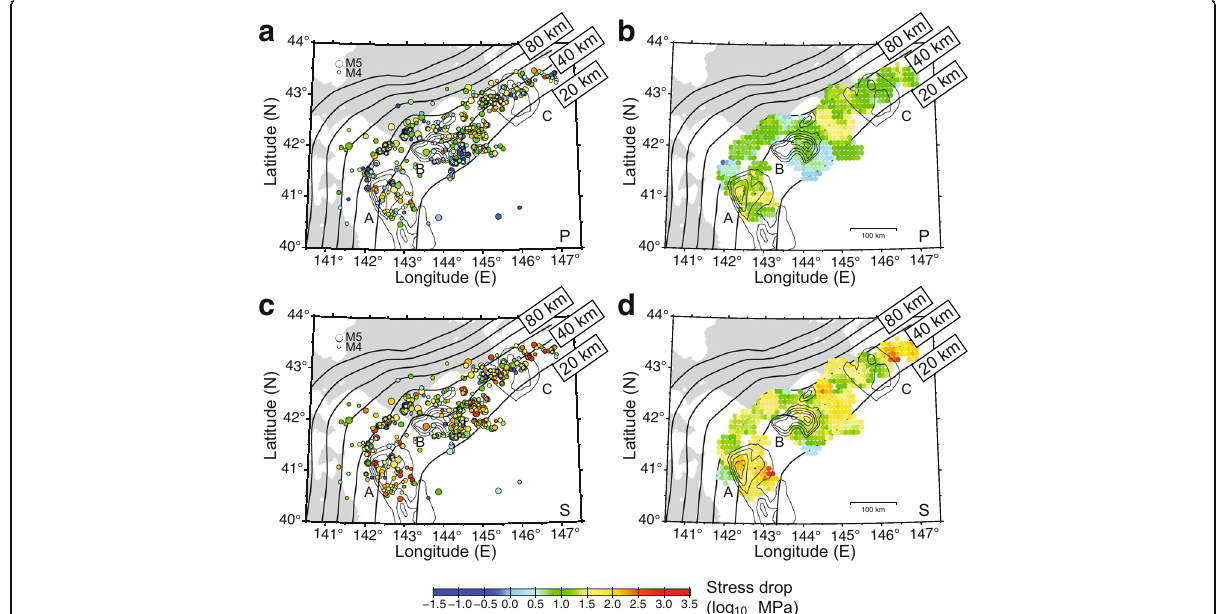
Fig. 4 a Stress drops for individual earthquakes estimated from P waves. The scale and color of circles indicate the earthquake magnitude and value of stress drop, respectively. The thick lines indicate the depth of the upper surface of the subducting Pacific Plate (Kita et al. 2010). Thin contours A through C show coseismic displacements for the 1968 Tokachi-oki (Nagai et al. 2001), 2003 Tokachi-oki (Yamanaka and Kikuchi 2003), and 1973 Nemuro-oki earthquakes (Yamanaka 2006), respectively, at intervals of 1 m. b Spatially smoothed stress drop derived from ( a ) at grid points at intervals of 0.1 degrees in latitude and longitude. The value at each grid point was calculated as the average of stress drops of earthquakes within 20 km of the epicentral distance from the grid point. Values were not assigned at grid points with less than four earthquakes within 20 km of the epicentral distance. c Stress drops estimated from S waves. d Map view of spatially smoothed stress drop derived from ( c )